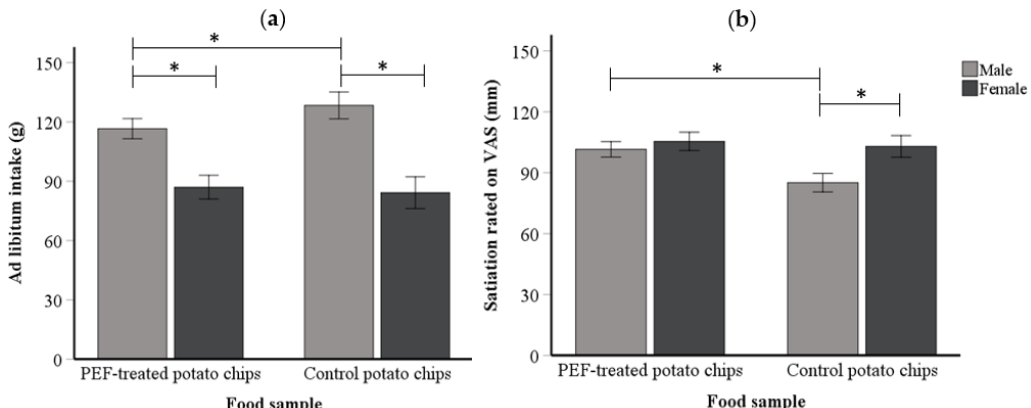
Figure 2. Comparison between genders on their ad libitum intake ( a ) and perceived satiation ( b ) of the PEF and control potato chips. The PEF-treated potato chip (associated with harder texture) refers to the potato chips treated with the pulsed electric fields (PEF) technology and the control potato chips refer to untreated with the PEF potato chips. The * indicates significant difference at p ≤ 0.05.